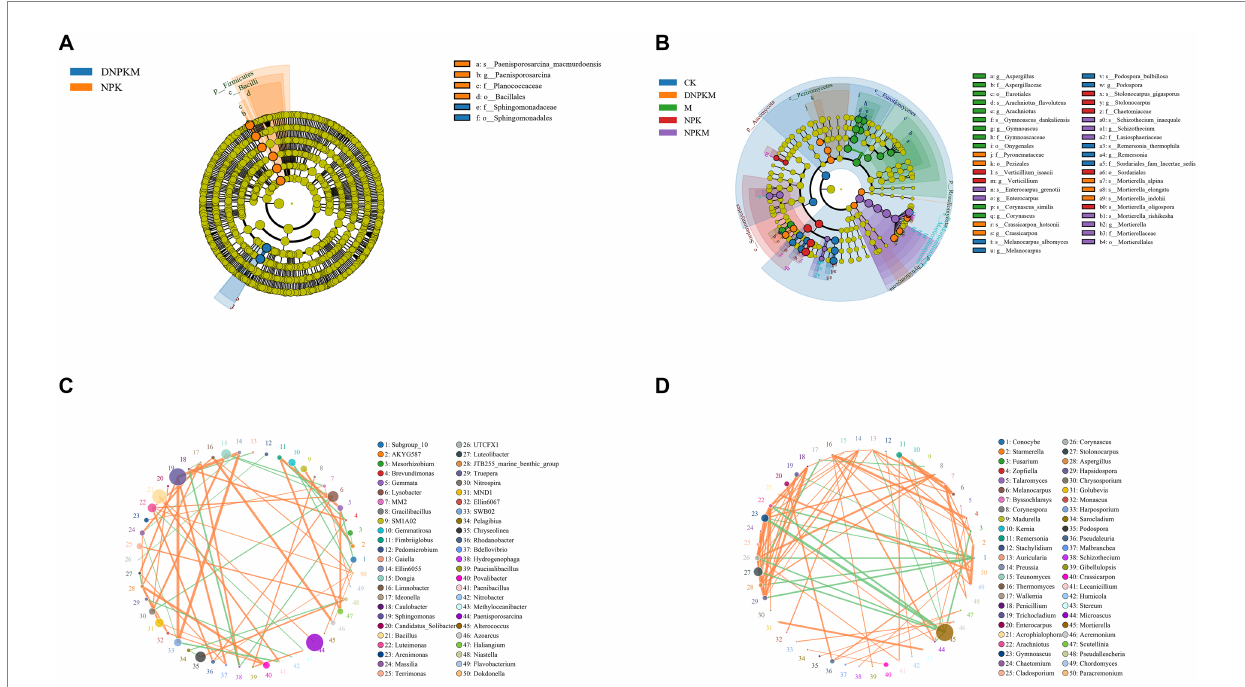
FIGURE 3 Lefse analysis to identify differential bacteria (A) and fungi (B) among different treatments. o, order; f, family; g, genus; s, species. The co-expression network of the bacterial community (C) and fungal community (D)